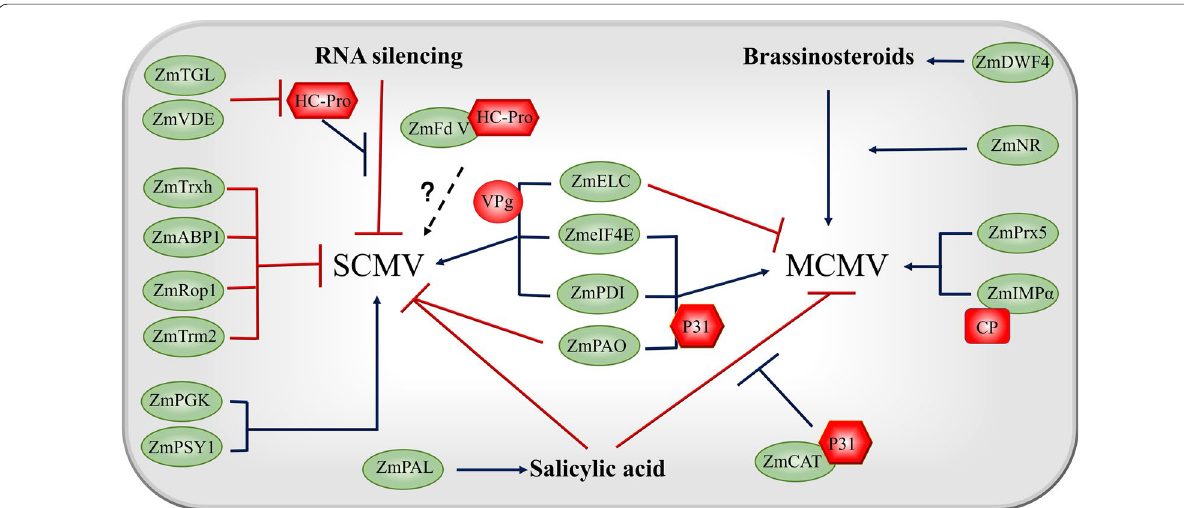
Fig. 3 Summary of molecular interplays between maize chlorotic mottle virus (MCMV)/sugarcane mosaic virus (SCMV) and maize plants. A simplified representation of the arms race between maize and viruses. Phytohormone, RNA silencing and (recessive) resistance genes pathways play important roles during maize-virus interactions. Arrows and lines with bars indicate positive and negative regulatory actions, respectively. The dotted line indicates that the role of ZmFd V on SCMV accumulation needs to be further investigated (question mark). ABP1, auxin-binding protein 1; CAT, catalase; CP, coat protein; DWF4, DWARF4; eIF4E, eukaryotic translation initiation factor 4E; ELC, Elongin C; Fd V, ferredoxin-5; HC-Pro, helper component-protease; IMPα, importin-α; NR, nitrate reductase; PAL, phenylalanine ammonia-lyase; PAO, polyamine oxidase; PDI, protein